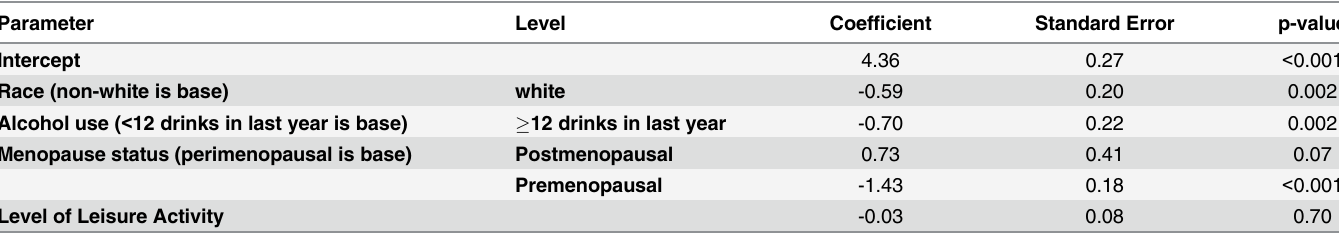
Table 2. Final model for duration of hot flashes in US women *